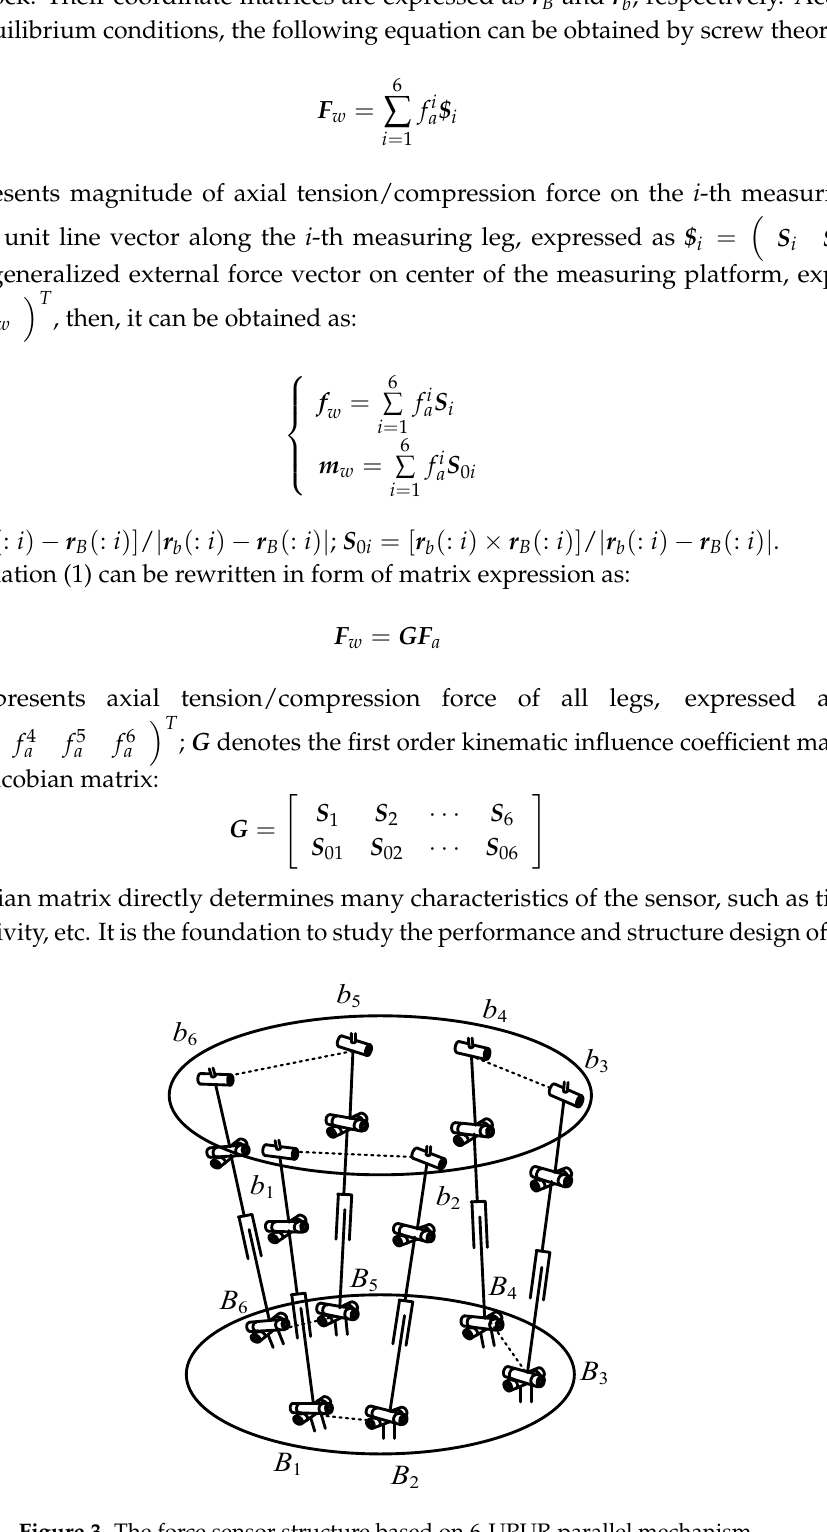
Figure 3. The force sensor structure based on 6-UPUR parallel mechanism.